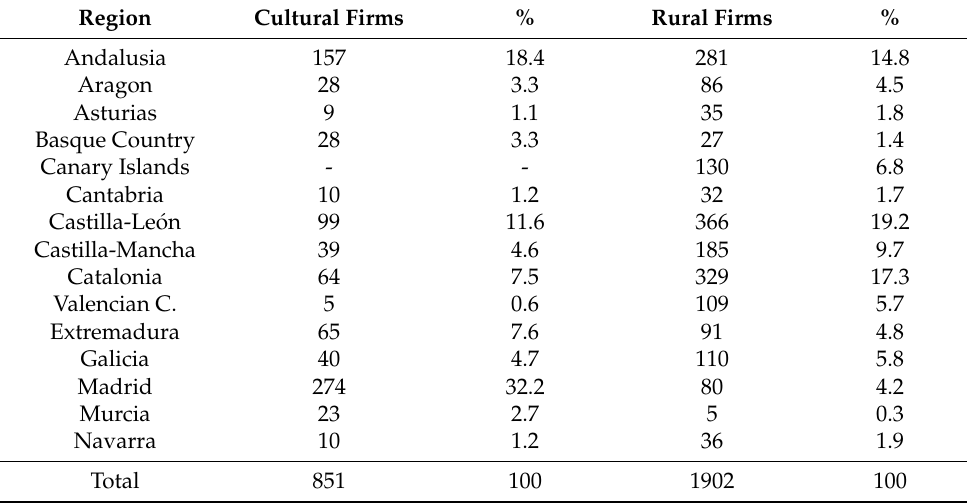
Table 3. Cultural tourism and rural tourism by